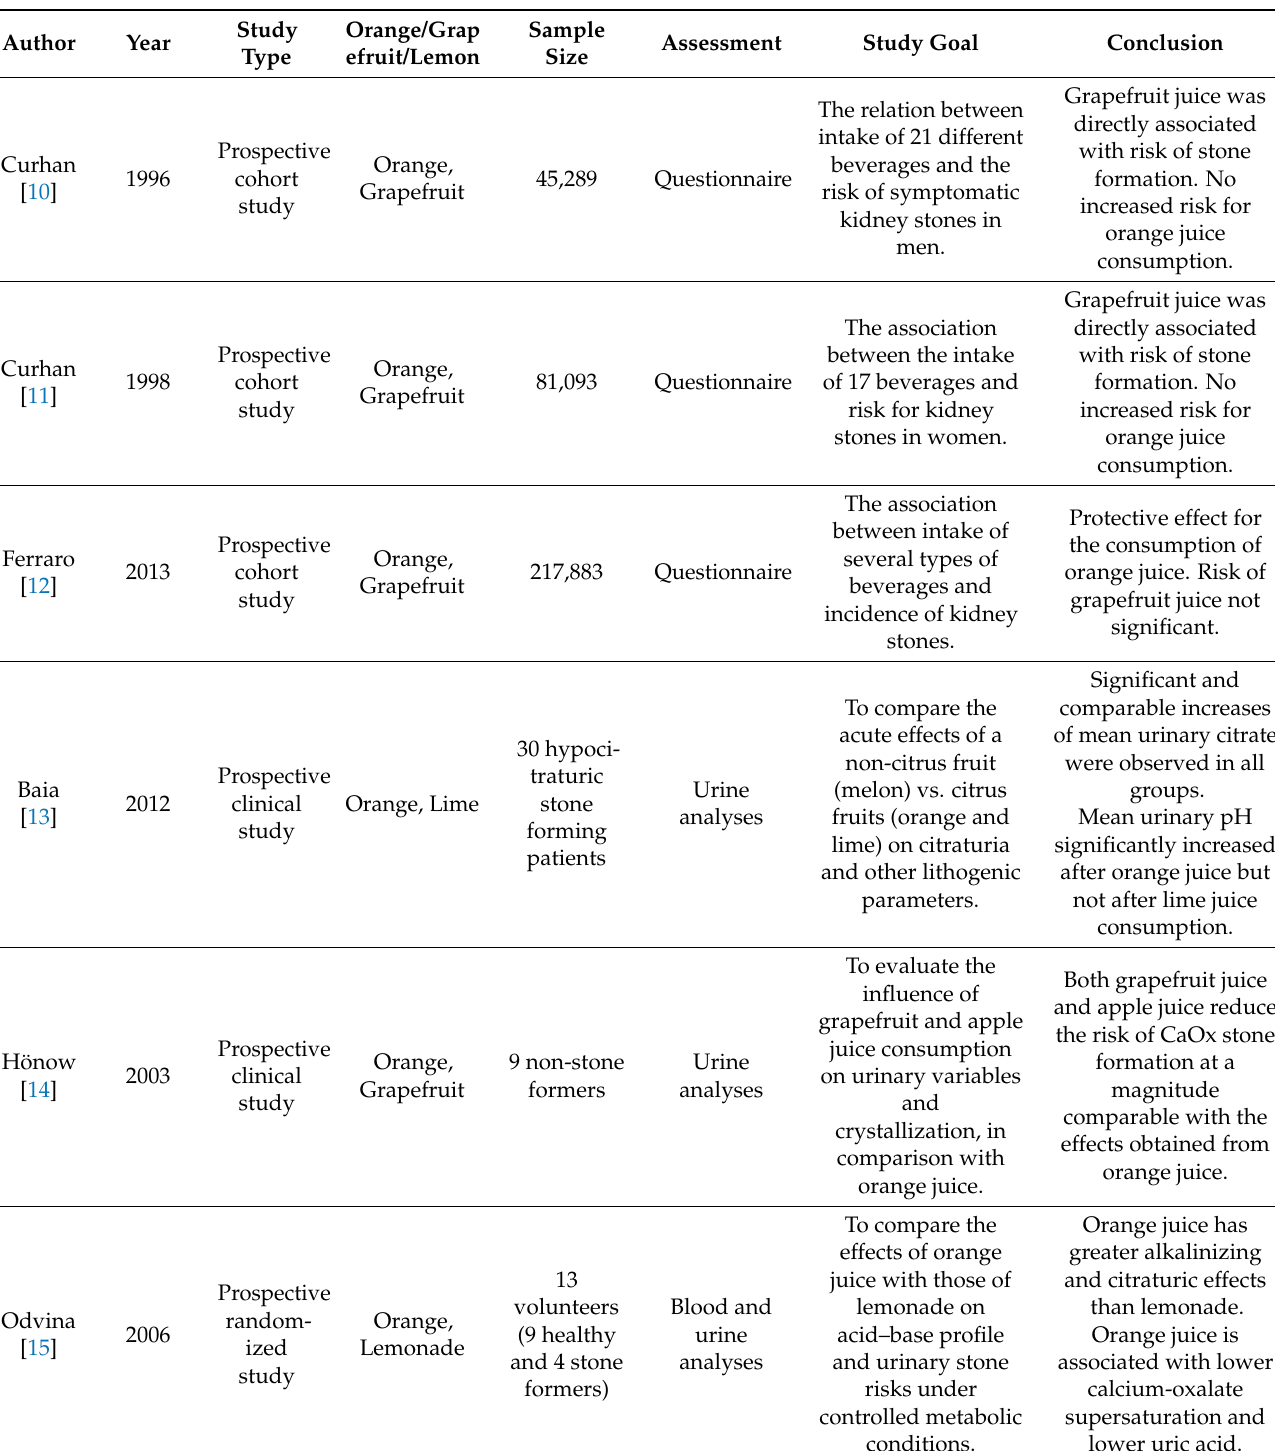
Table 1. Summary of the main experimental studies of orange, grapefruit, and lemon juice intake and urinary stone